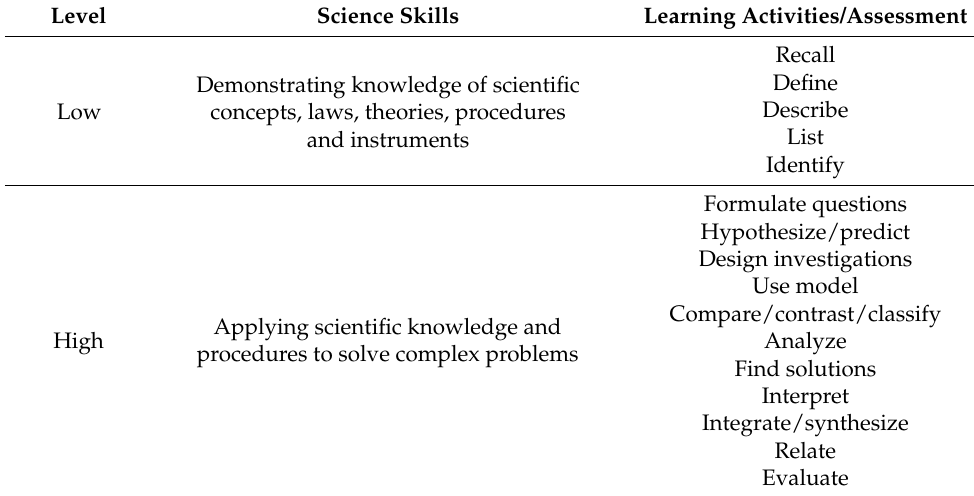
Table 3. Higher order thinking behaviors.